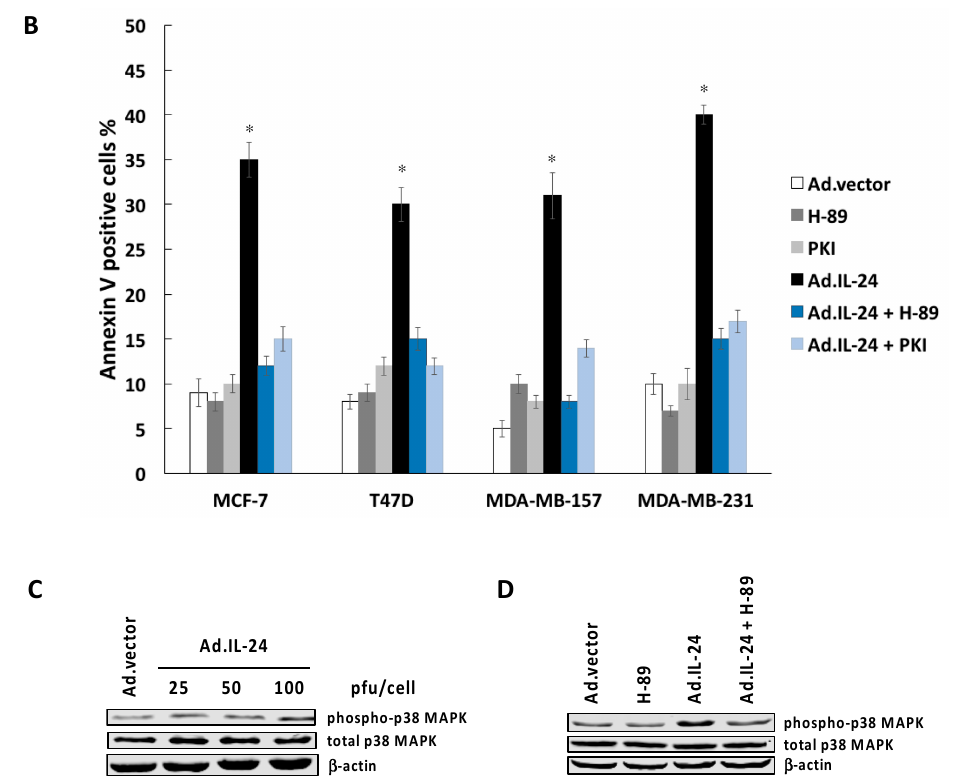
Figure 3. The IL-24 killing effect is decreased in the presence of PKA inhibitors. ( A ) Human breast MCF-7, MDA-MB-231, MDA-MB-157, and T47D cancer cells were incubated with 10 µ M of PKA inhibitor, H-89, or PKI, with or without Ad.IL-24 (100 pfu per cell) or Ad.vector (100 pfu per cell), and cell viability was determined by the MTT proliferation assay five days after treatment. Numbers represent the ratio of specific treatments to values in control cells (Ad.vector). An average of three independent experiments is shown ± SD as errors bars. *, p < 0.001 comparted to Ad.vector. ( B ) Cells were treated as described in A, and then assayed for cell death using annexin V staining, a measure of apoptosis, was determined 48 h later by fluorescence-activated cell sorting (FACS) analysis using the CellQuest software (Becton Dickinson). An average of three independent experiments is shown ± SD as errors bars, *, p < 0.001 comparted to Ad.vector. ( C ) MCF-7 cells were treated for 24 h with Ad.IL-24 (25, 50, and 100 pfu per cell), 10 µ M H-89 or Ad.vector (100 pfu per cell). Cells were collected, protein purified, and subjected to Western blot analysis to detect phospho-p38 MAPK, total p38 MAPK, and β -actin. ( D ) MCF-7 cells were infected with either Ad.vector (control) or Ad.IL-24 at 100 pfu/cell, and either untreated or treated with 10 µ M H-89 for 72 h. Western blot analysis was performed with antibodies for phospho-p38 MAPK, total p38 MAPK, and β -actin.